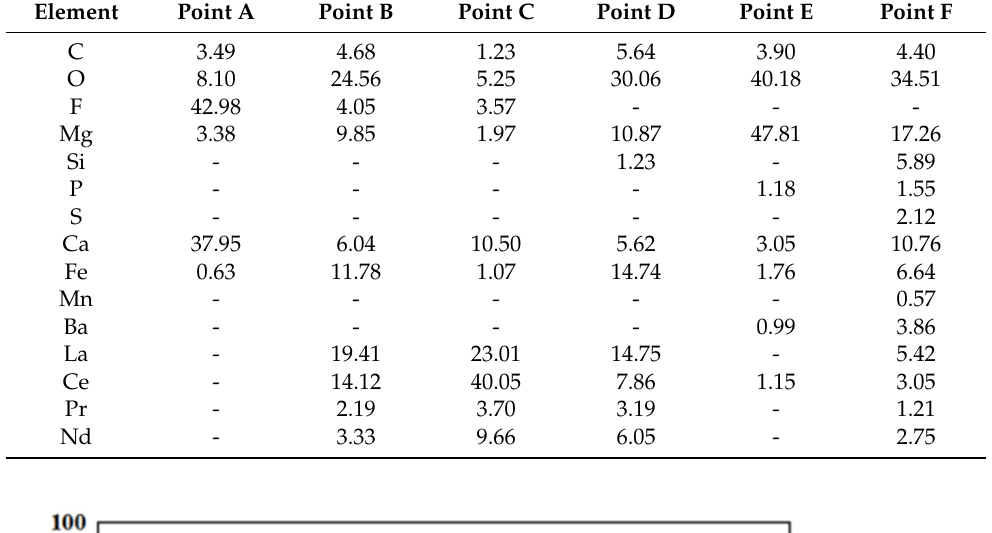
Table 2. EDS analysis results of points in Figure 6 (wt.%).